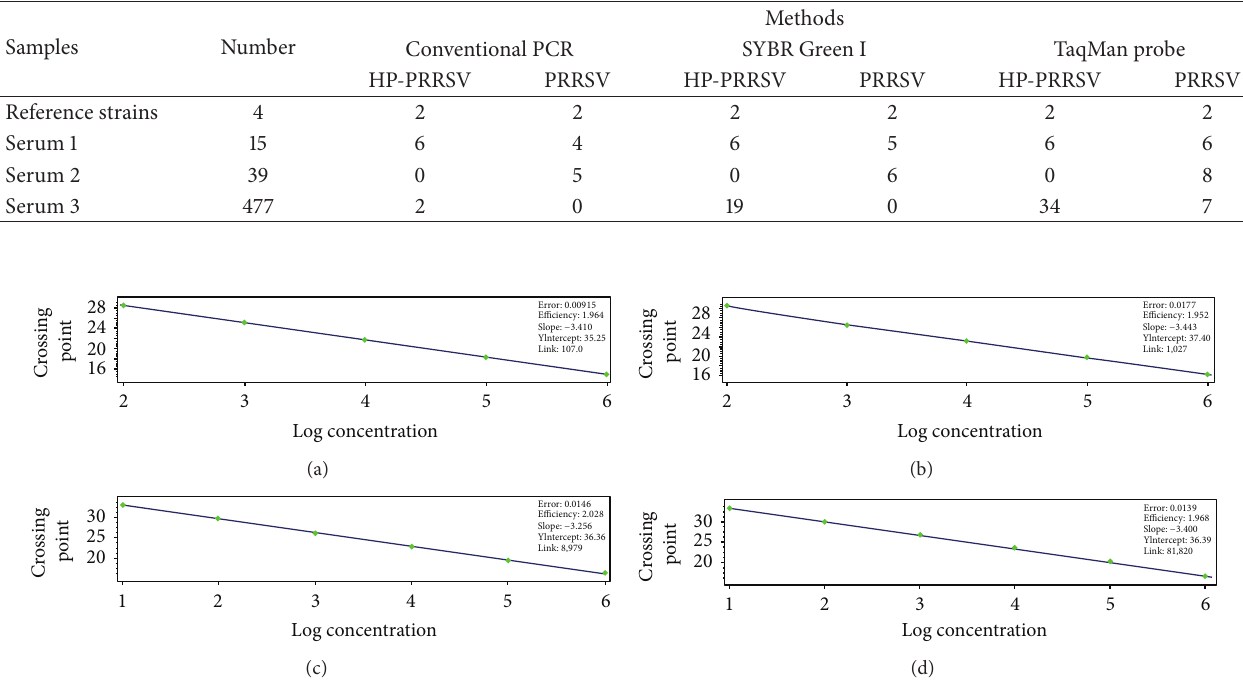
Figure 2: Standard curves were generated based on Cp values of 10-fold dilutions of plasmid DNA. Regression lines between the Cp ( 𝐶 𝑇 ) values and the input concentrations of HP-PRRSV (a) and PRRSV (b) plasmid DNA in real-time RT-PCR detected using SYBR Green I and HP-PRRSV (c) and PRRSV (d) using TaqMan probe,